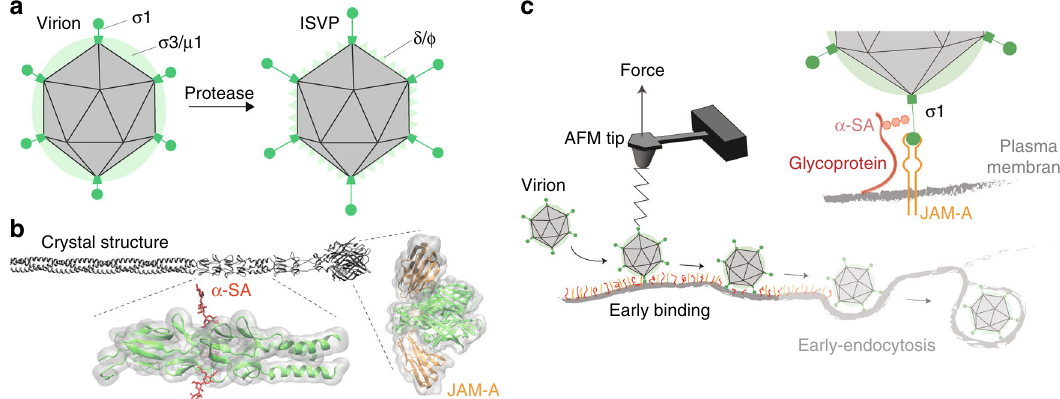
Fig. 1 Probing reovirus binding to living cells. a Schematic of reovirus particles with outer-capsid proteins labeled before (virion) and after (infectious subvirion particle [ISVP]) proteolytic processing. The cartoon shows the arrangement of outer-capsid proteins in the double-layered shell of virions, the formation of ISVPs by removal of σ 3 and cleavage of µ 1 to yield δ and ϕ , and rearrangement of σ 1 into a more elongated conformation. b Full-length model of reovirus σ 1 protein 28 , which functions as the viral attachment protein that binds to cell-surface glycans (in particular, to terminal α -linked sialic acid [ α -SA] residues) and junctional adhesion molecule-A (JAM-A). Regions of the molecule that interact with α -SA and JAM-A are indicated. c Schematic of probing reovirus entry using AFM. The initial attachment of reovirus to cells involves speci fi c binding between the viral σ 1 protein and the receptor, JAM-A. Cell-surface glycans serve as attachment factors, and virus binding to their α -SA groups function in the initial association of virus to cells and